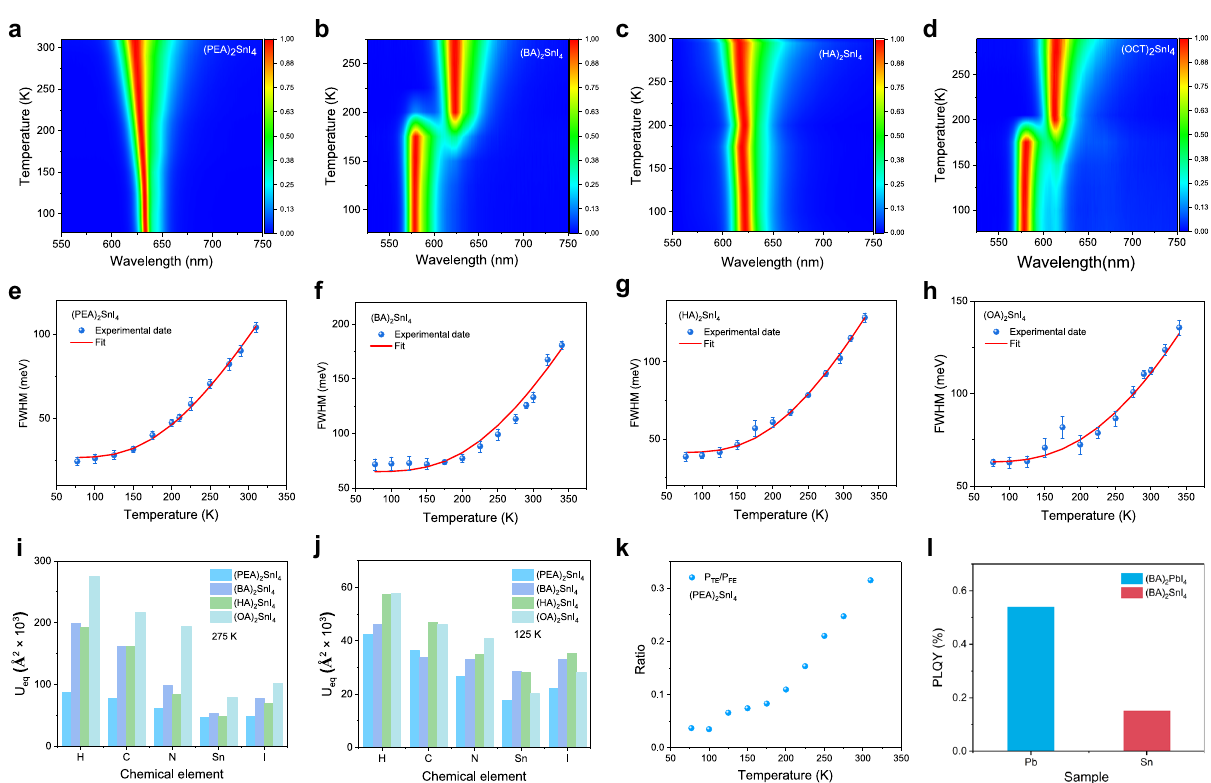
Fig. 3 Analysis of exciton – phonon coupling effects of the four perovskites. Contour map of the temperature-dependent normalized PL spectra: a (PEA) 2 SnI 4 , b (BA) 2 SnI 4 , c (HA) 2 SnI 4 , and d (OA) 2 SnI 4 fi lms obtained under continuous wave (CW) laser excitation at a wavelength of 473 nm, a power density of 2 µ J cm − 2 , and from 300 to 77 K with 25 K intervals. The color scales represent the intensity of normalized PL. Temperature-dependent FWHM for e (PEA) 2 SnI 4 , f (BA) 2 SnI 4 , g (HA) 2 SnI 4 , and h (OA) 2 SnI 4 . The blue dot represents the experimental data, the short lines above and below the blue dots represent the error bars, and the red solid lines represent the fi tting results of the exciton – phonon coupling model (3) in Supplementary Note 6. Average atomic displacement U eq of chemical elements ( H , C , N , Sn , and I ) in (PEA) 2 SnI 4 , (BA) 2 SnI 4 , (HA) 2 SnI 4 , and (OA) 2 SnI 4 at i 275 K and j 125 K extracted from single-crystal X-ray diffraction (SCXRD) data (Supplementary Information). k Characteristics of the ratio (P TE /P FE ) of trapping -state exciton PL intensity to free exciton PL intensity as a function of temperature. l the PLQY of (BA) 2 PbI 4 and (BA) 2 SnI 4 obtained under the same experimental